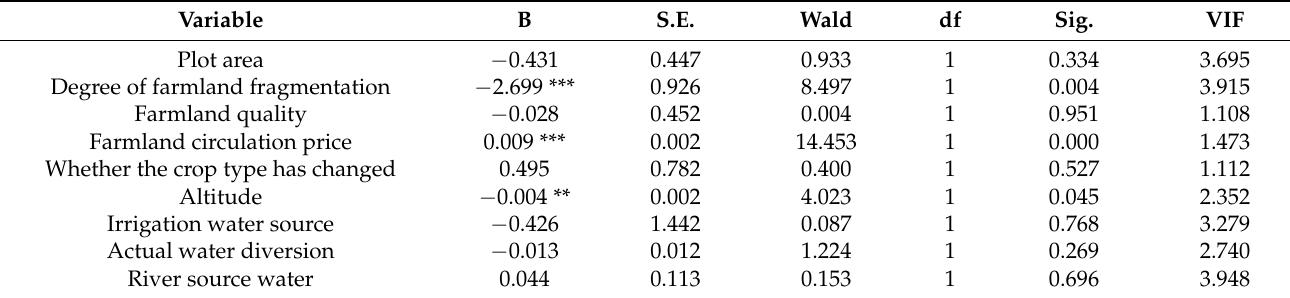
Table 8. Logistic regression results at plot level in mountainous